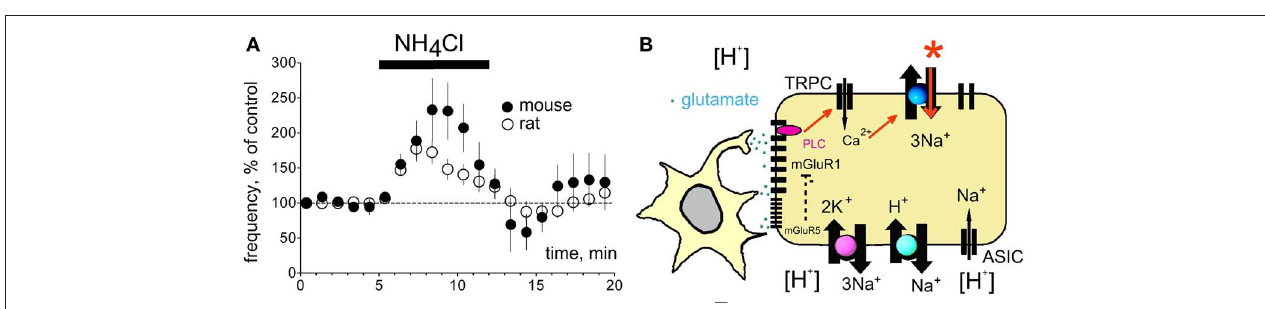
FIGURE 7 | Mouse TMN neurons resemble those of the rat but hardly respond to pH 7.0 and DHPG. (A) Histamine (AF488) co-localization with Tmt protein (expressed in HDC-Cre positive neurons). Note, that virtually all red cells are histamine-positive, but some histamine + cells do not express HDC-Cre (few cells are indicated by arrows). Scale bar 100 μ m. (B) The H3 receptor agonist R-( α )-methyl histamine (RAMH, 2 μ M) similarly decreases firing rate of mouse WT ( n = 5) and Tmt + ( n = 6) TMN neurons. (C) Relative levels of mRNAs encoding for the markers of histaminergic activity in TMN